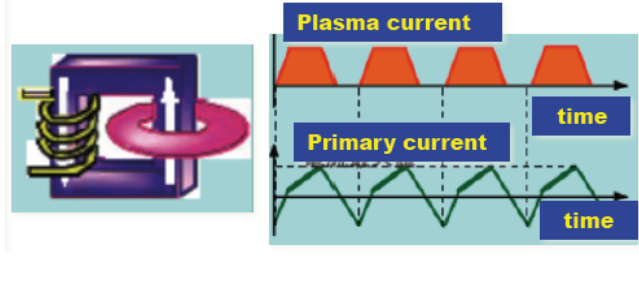
Figure 6. Schematic view of the inductive operation of a tokamak. Change in the primary current induces a toroidal electric field to drive and sustain the plasma